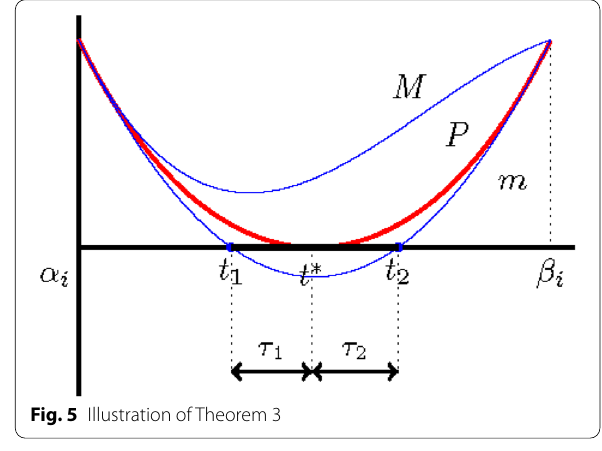
Fig. 5 Illustration of Theorem